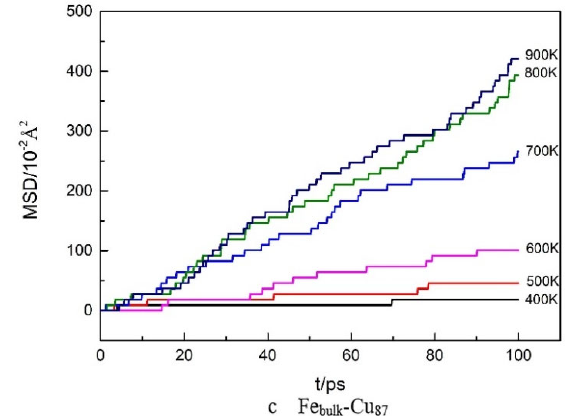
Figure 2. Mean square displacements of Cu atoms in Fe bulk –Cu n , n = 13 ( a ), 43 ( b ) and 87 ( c ). Figure 3 shows PDFs of the three Cu clusters at different temperatures. For the Fe bulk - Cu 13 as shown in Figure 3a, there are distinct peaks at the positions of 0.0869, 0.1004, 0.1418, 0.1665, 0.2013, 0.2220, 0.2465 and 0.2616 nm at 400 K. With the increase in the temperature, the height of these peaks become low, and they widen. However, at 800 K, some peaks disappear, implying changes in the atomic packing of these Cu atoms. For the cases of Fe bulk –Cu 43 and Fe bulk –Cu 87 , shown in Figure 3b,c, the PDFs also indicate that only at high temperatures, are there a few atoms adjusting their positions.